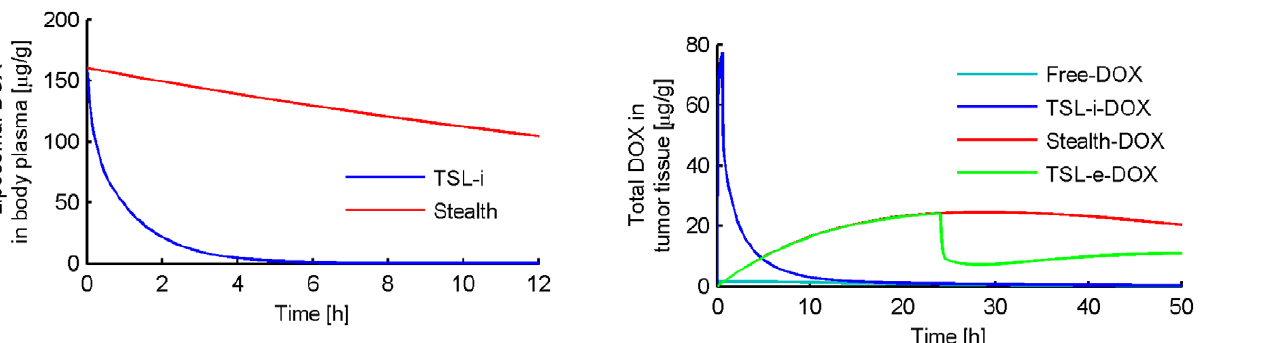
Figure 4. Total DOX (including liposomal and bioavailable) in tumor tissue (EES and intracellular) for different DOX formula- tions.